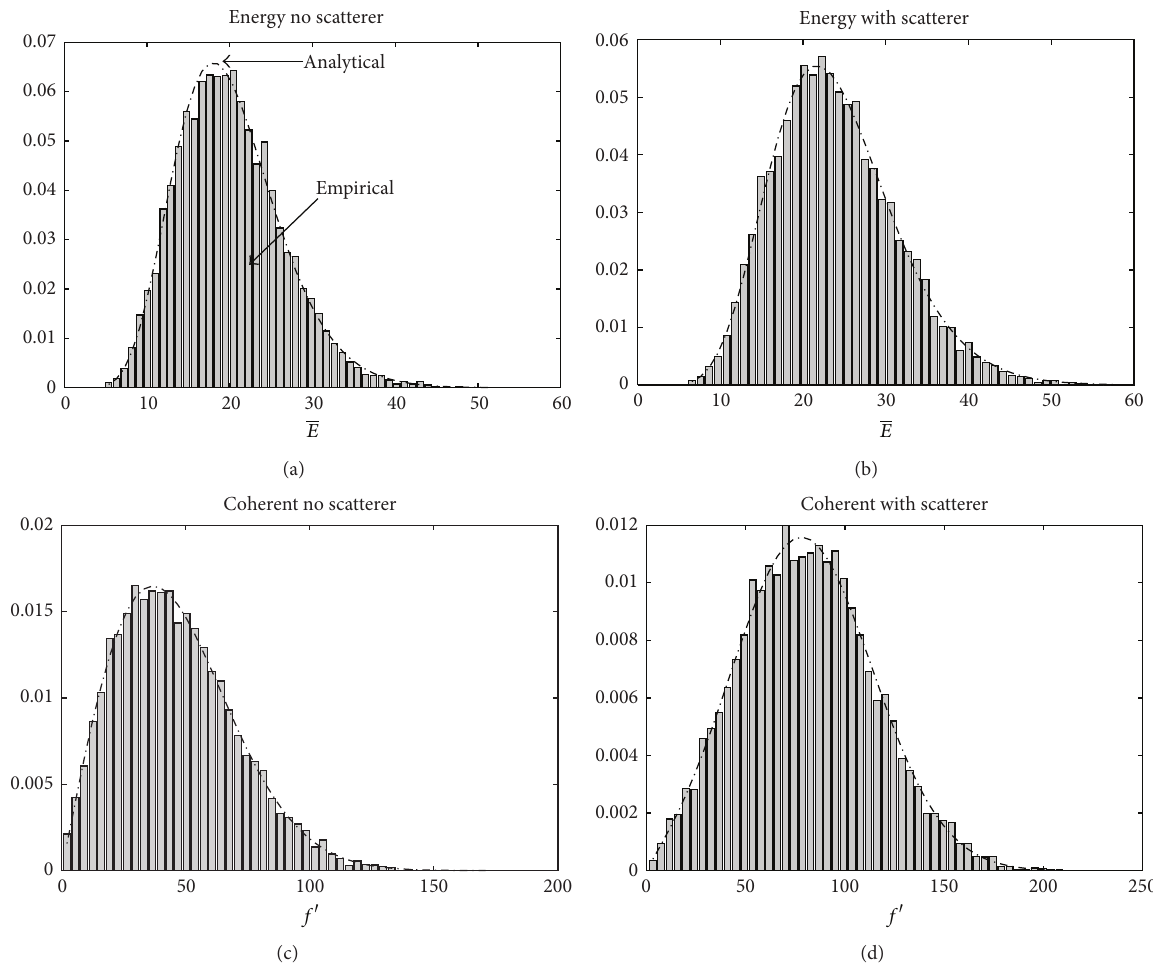
Figure 3: Histograms for scatterer detection in a waveguide of perfectly reflecting